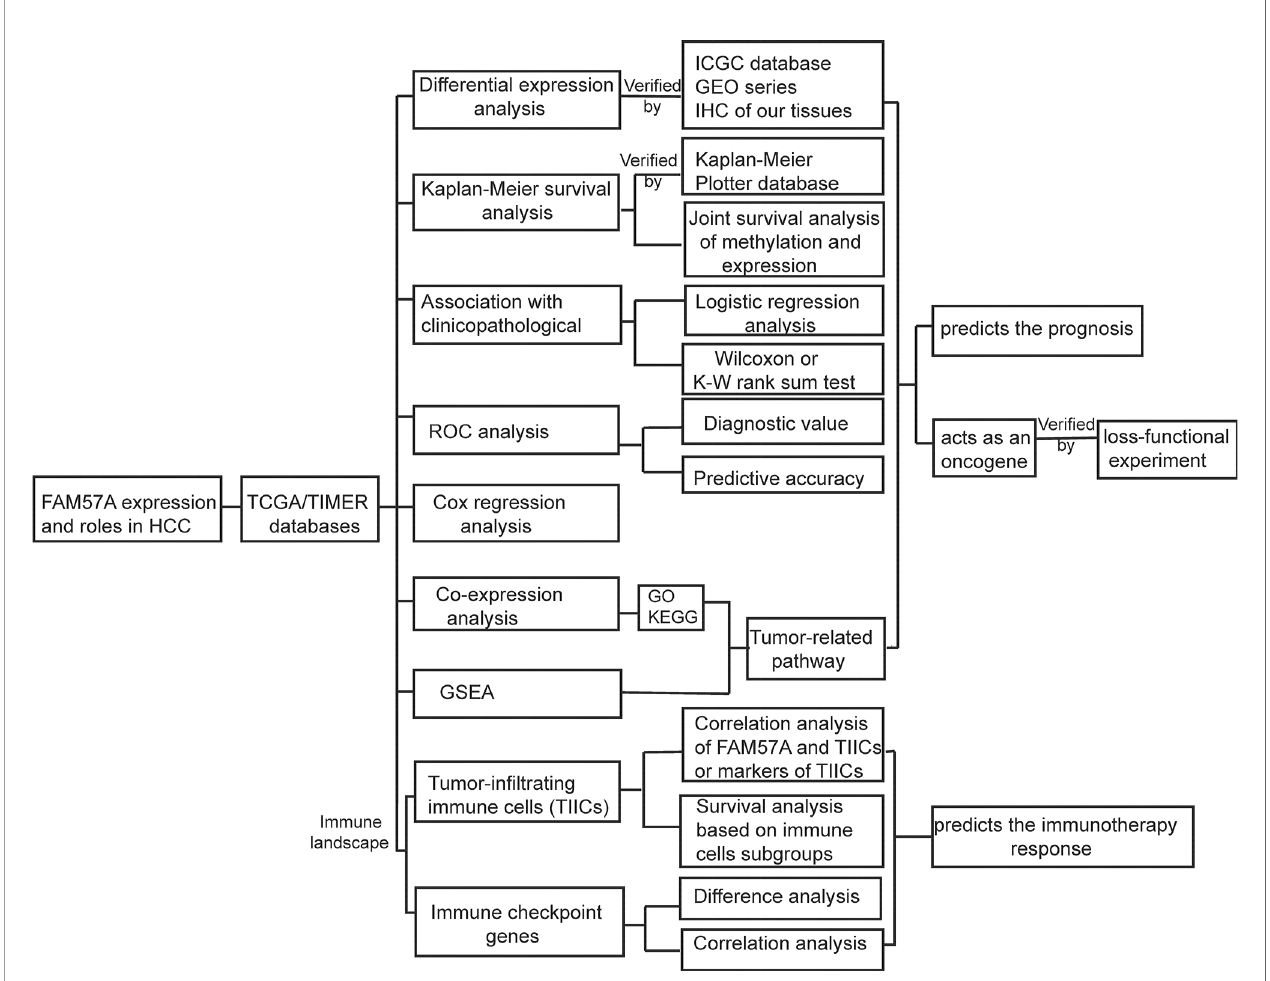
FIGURE 1 | Analysis work fl ow of this study. GSEA, Gene set enrichment analysis; GO, Gene Ontology; HCC, hepatocellular carcinoma; IHC, immunohistochemistry; KEGG, Kyoto Encyclopedia of Genes and Genomes; ROC, receiver operating